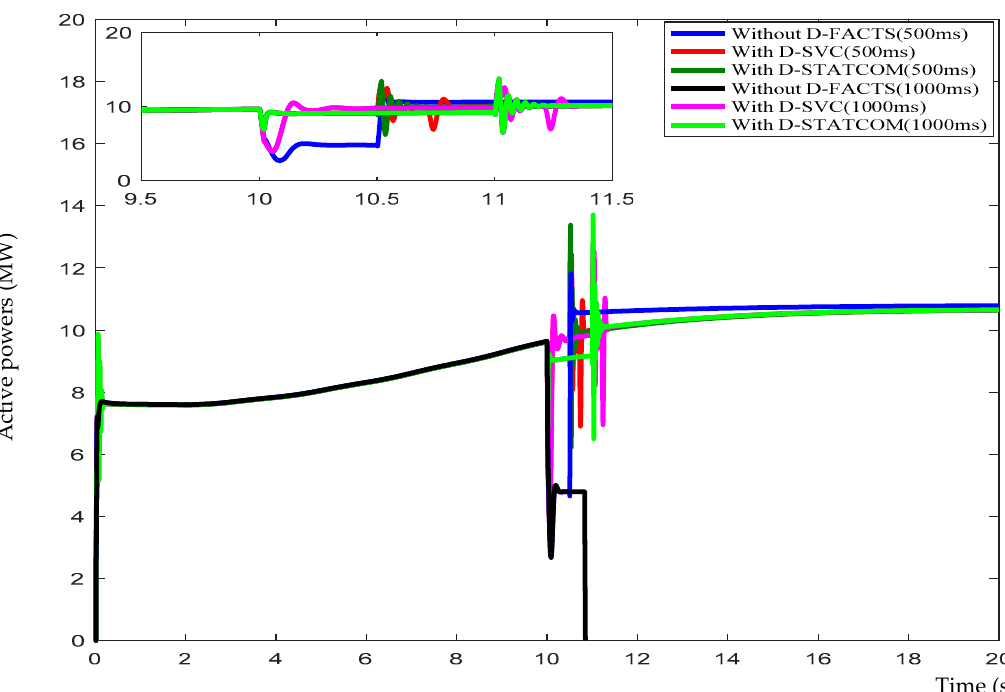
Figure 17. Active power at the PCC during the voltage drop at the 60 kV bus.